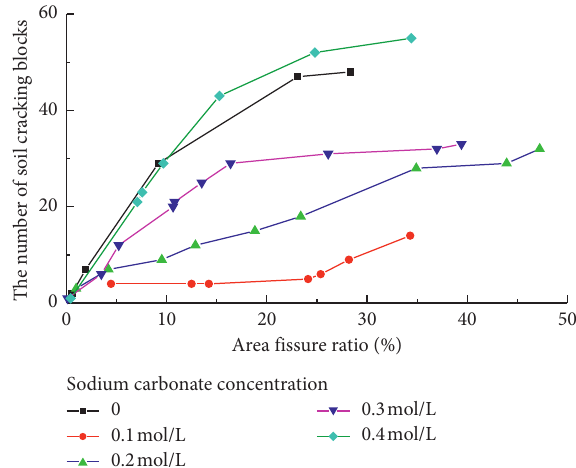
Figure 2: The curves of water loss rate and time of soil contam- inated by sodium carbonate.